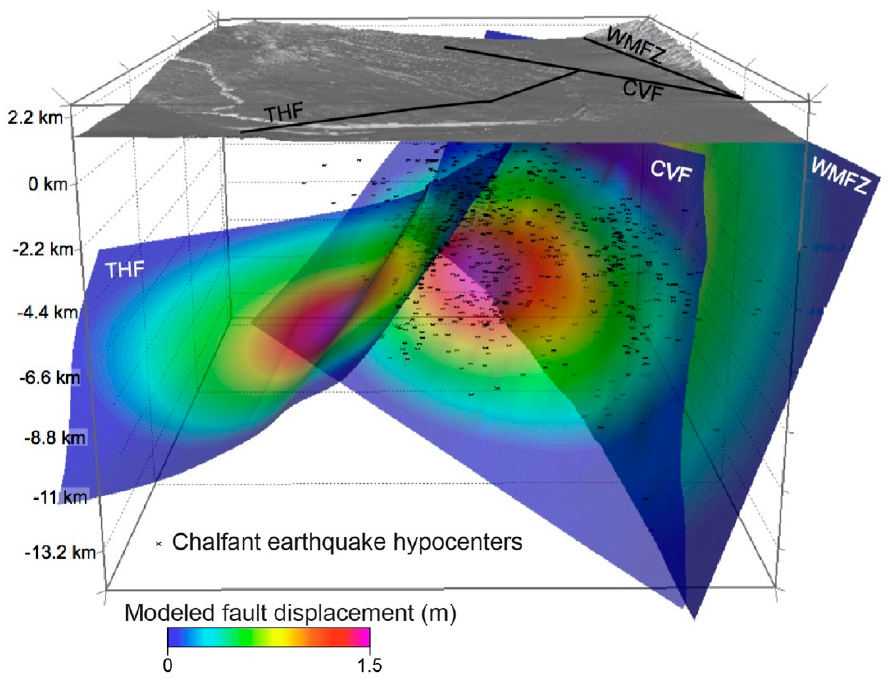
Figure 10. 3D fault model showing the Tungsten Hills Fault (THF), Chalfant Valley Fault (CVF), and the White Mountain Fault Zone (WMFZ) calculated from USGS earthquake data of the 1986 Chalfant Earthquake sequence. Slip magnitudes on each fault were assigned [29,36]. Modeled fault displacements are colored by slip magnitude, with pink and red representing the area of maximum displacement in each fault centroid tapering to zero displacement (blue). Earthquake hypocenters are plotted for comparison.